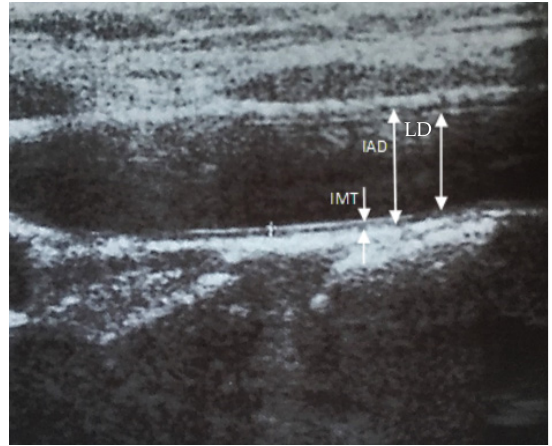
Figure 1. Diagram of the common carotid artery in ultrasound examination. IMT—intima media thickness, IAD—interadventitial diameter; LD—lumen